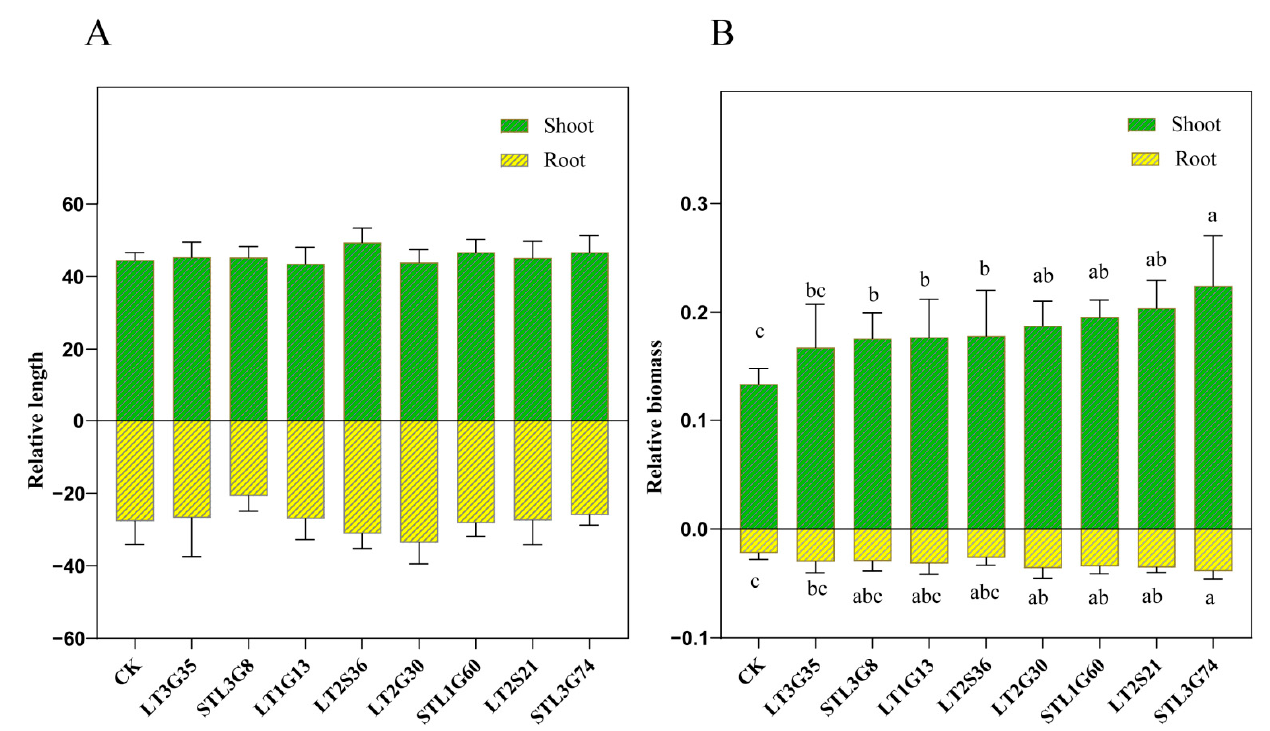
Figure 6. The relative length ( A ) and relative biomass ( B ) of Lolium perenne inoculated with different isolates. Different letters in each column denote that mean values are significantly different ( p < 0.05), means ± SD ( n = 10).